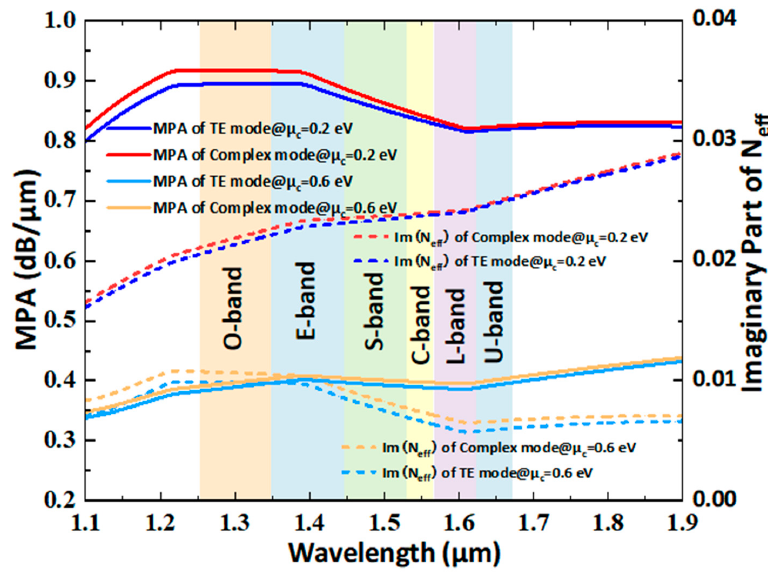
Figure 18. Re( N eff ) and Re( ∆ N eff ) of the TE mode and the complex mode vary with wavelength.